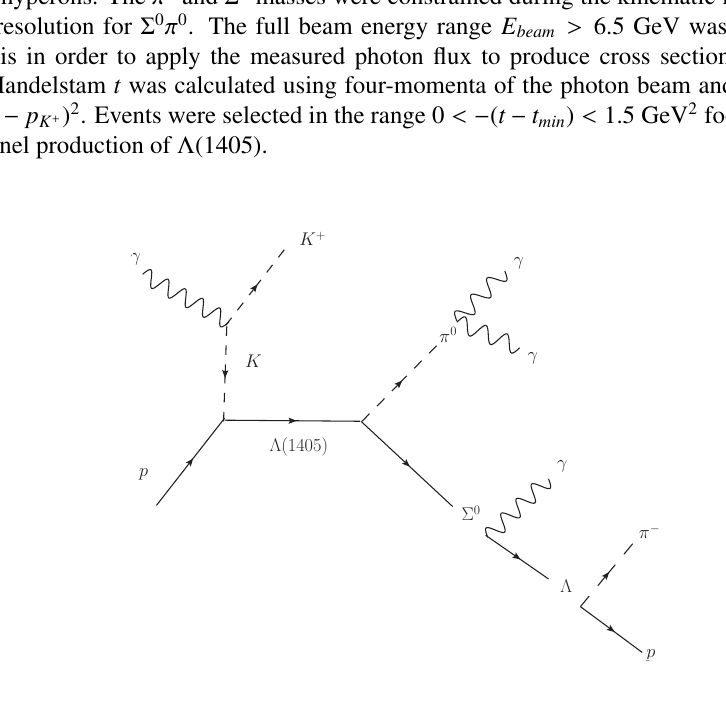
Figure 1: The decay chain of the reaction γ p